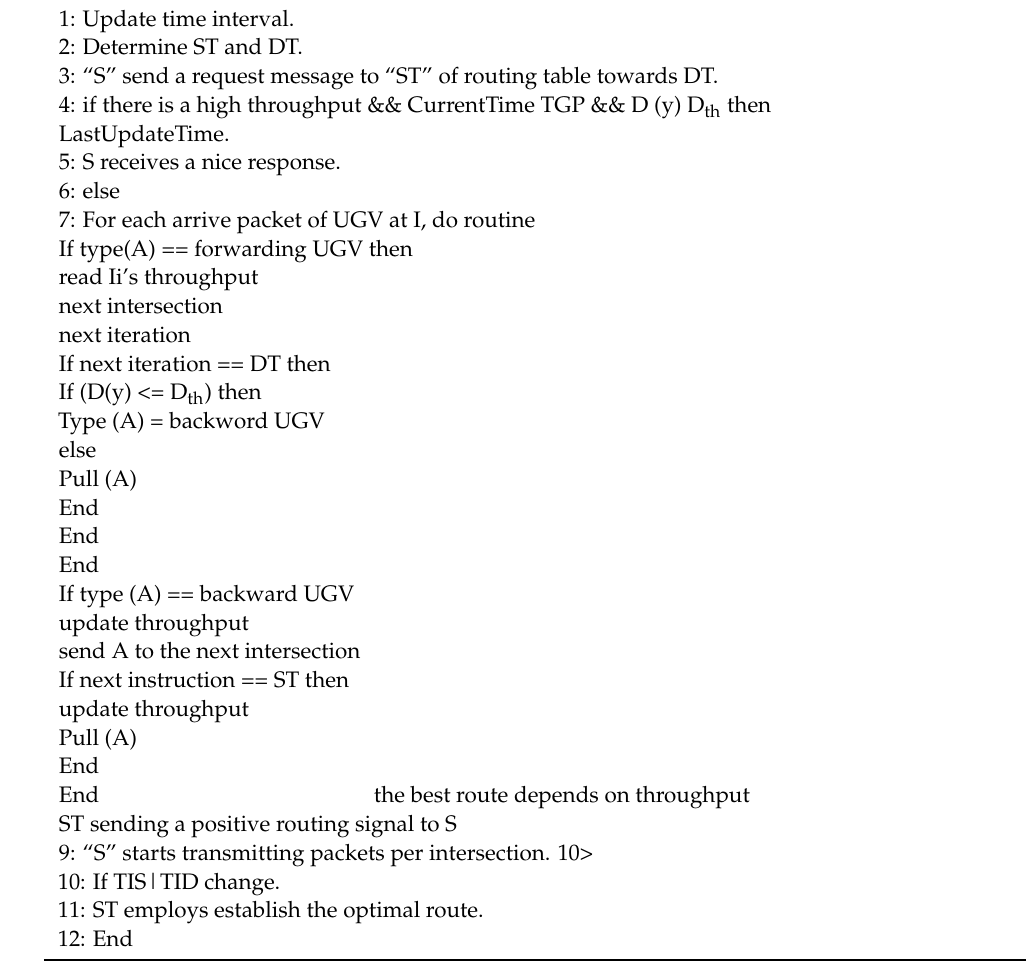
Algorithm 1: Firefighting UGV Routing Algorithm